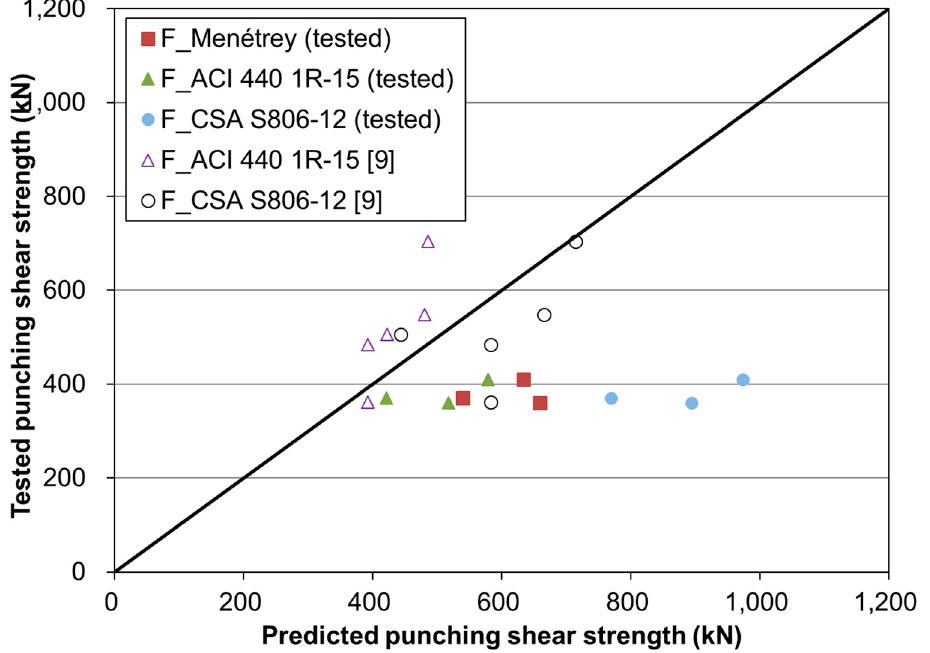
Figure 10. Results of tested and predicted punching shear strength.